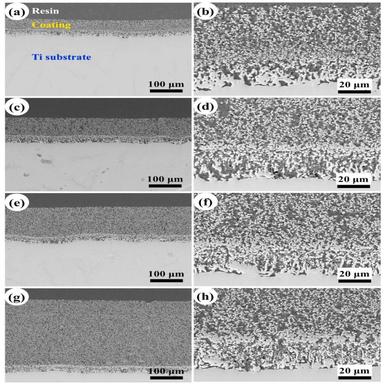
Cross-sectional morphology of the TiO2 coating with different thicknesses after sintering at 1000 ◦C for 1 h, (a, b) 40 μm, (c, d) 78 μm, (e, f) 118 μm, and (g, h) 246 μm.